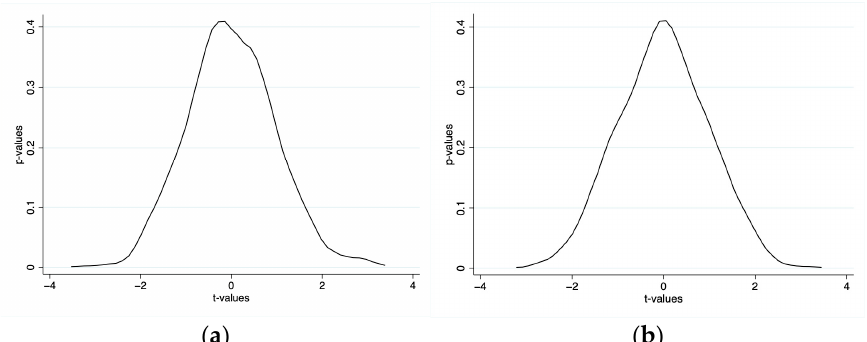
Figure 5. Placebo effect. ( a ) Out-of-pocket medical expenses: bandwidth = 0.2241 (Kernel: Epanechnikov); ( b ) Self-rated health: bandwidth = 0.2165 (Kernel: Epanechnikov). Note: The X -axis is the t -value, the Y -axis is the p -value, and the curve is the kernel density estimated